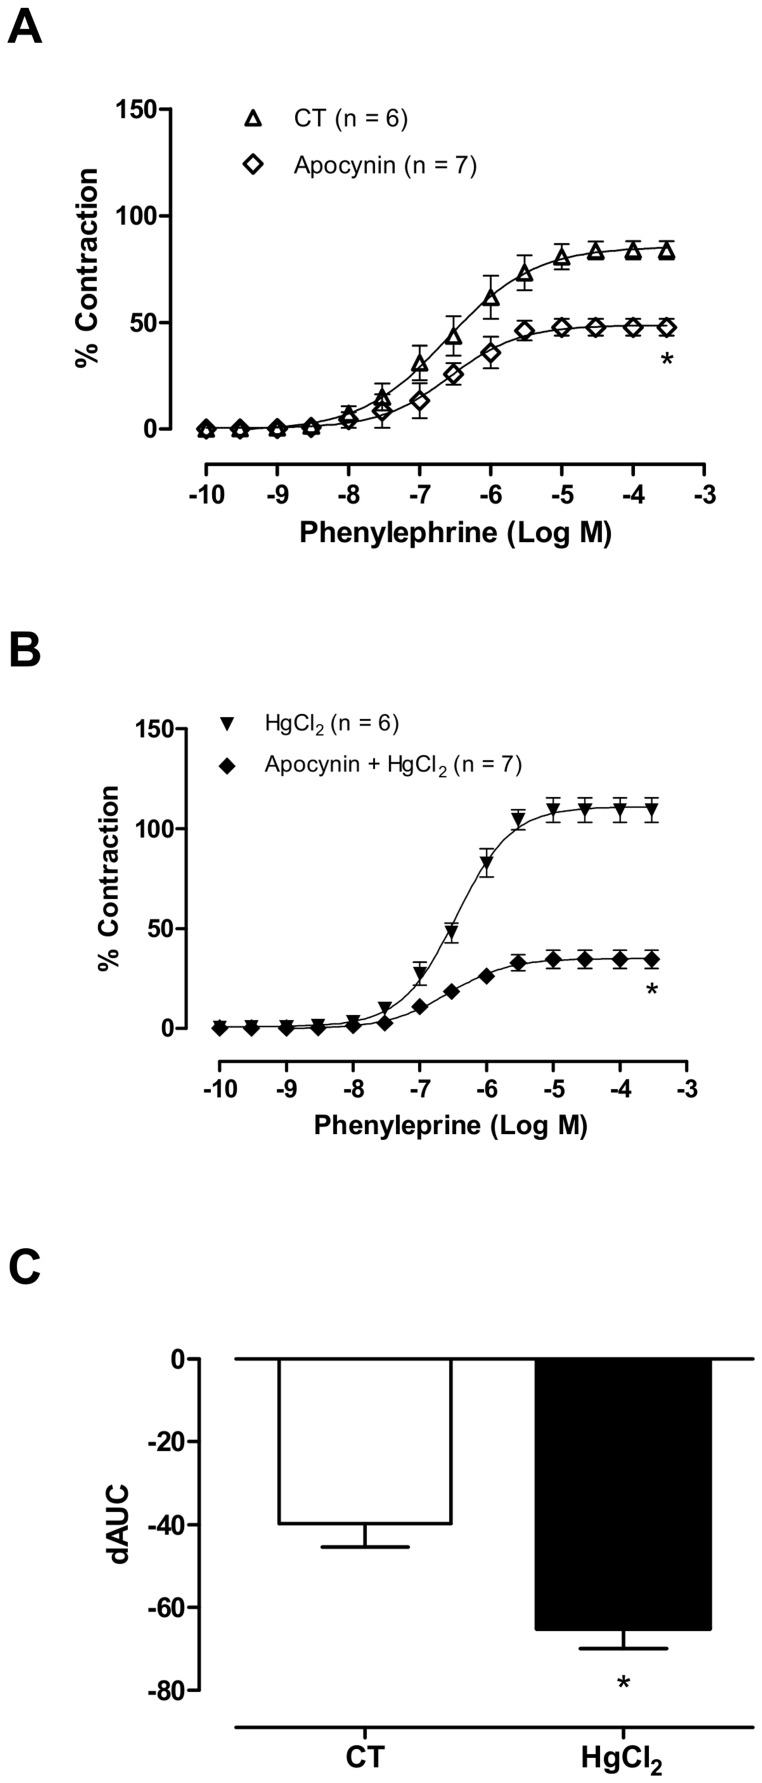
The effect of apocynin (0.3 mM) on the concentration-response curves for phenylephrine in aortic rings in control (CT) conditions or HgCl2 (A,B).Results (mean±SEM) are expressed as a percentage of the response to 75 mmol/l KCl. *P<0.05 by ANOVA. Number of animals used in parentheses. (C) Differences in the area under the concentration-response curve (dAUC) in aortic rings cultured the presence and absence apocynin (0.3 mM), under control (CT) conditions or HgCl2. *P<0.05 by Student’s t-test.